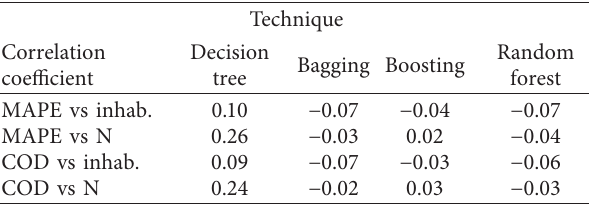
Table 1: Linear correlation coefficients between the MAPE and COD values obtained from the 433 municipalities where the val- uations and population sizes (inhab.) and sample sizes (N) of said municipalities have been